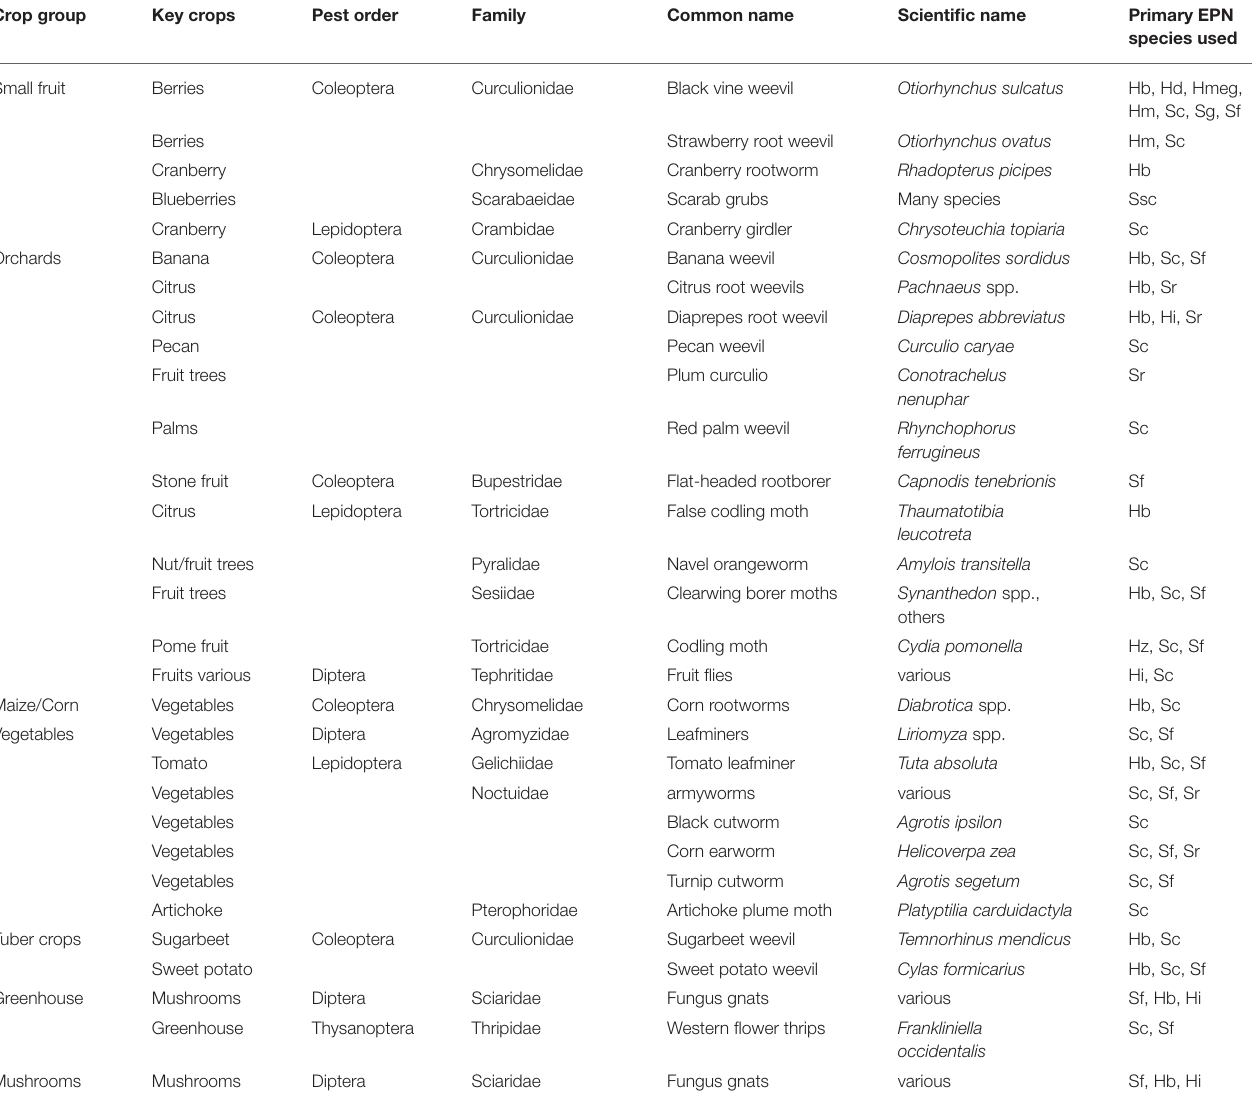
TABLE 2 | Food crops with major target pests on which entomopathogenic nematodes have been used commercially or have shown promise a,b . Crop group Key crops